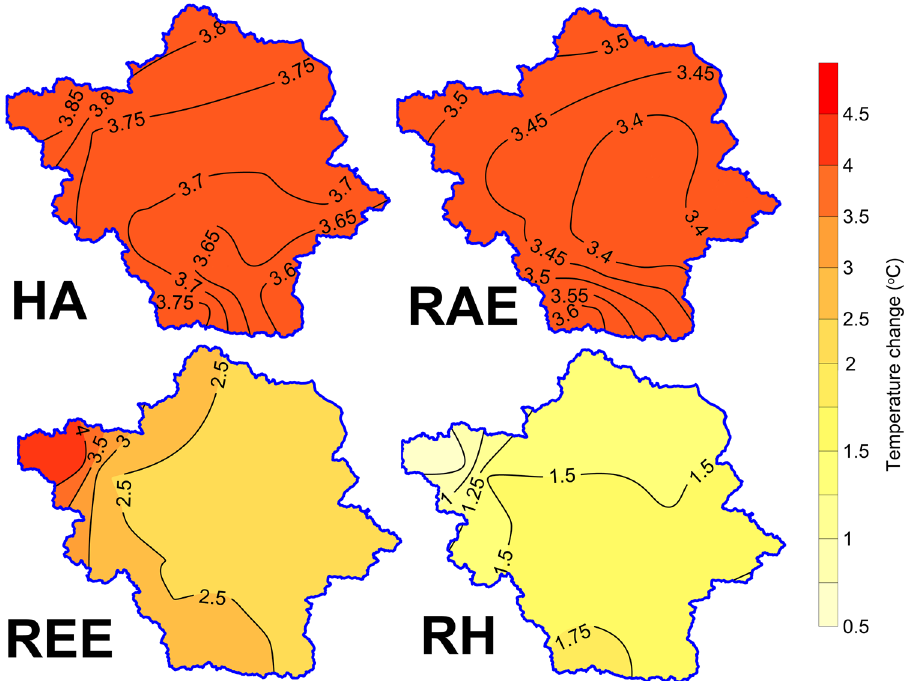
Fig. 9 Spatial distribution of average annual temperature change for the period 2021– 2100 for each RCM–GCM